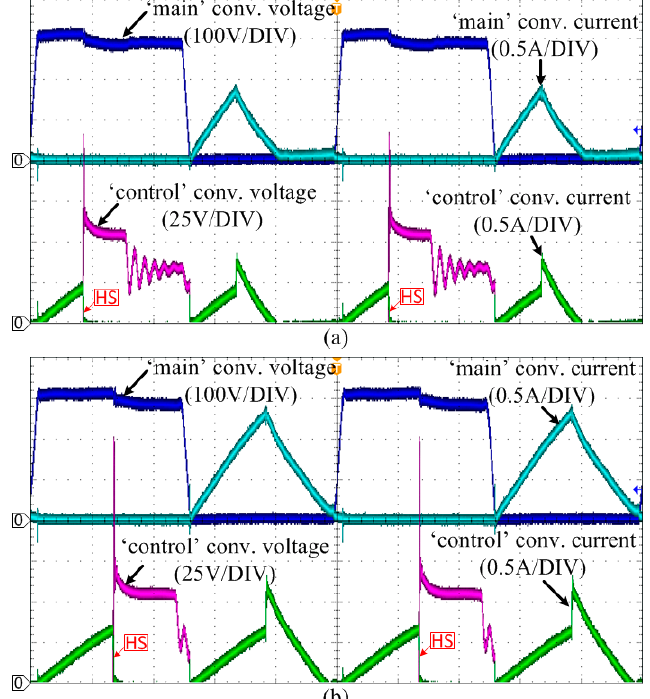
Figure 16. Voltage and current waveforms in the IGBT switch (output-side) when the BiDUP converter operates in the backward mode with the ‘control’ converter duty-ratios of ( a ) − 0.15 and ( b ) − 0.25, respectively.